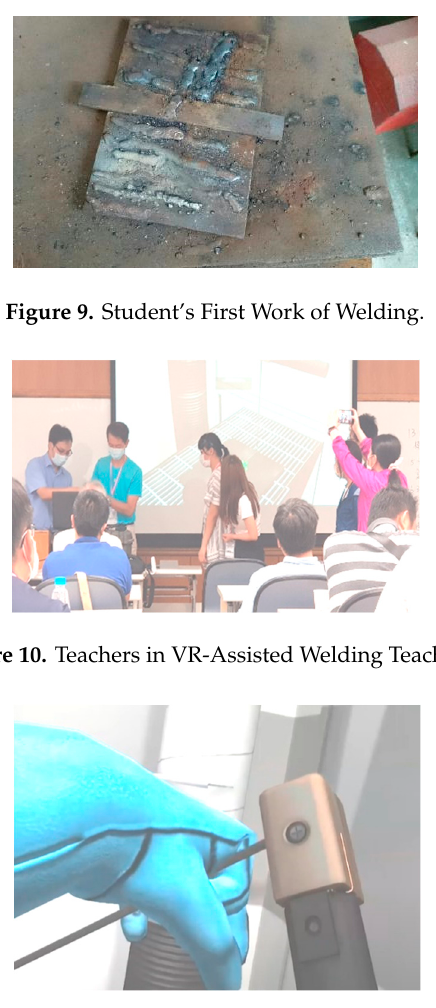
Figure 11. VR Welding Simulation Screen.